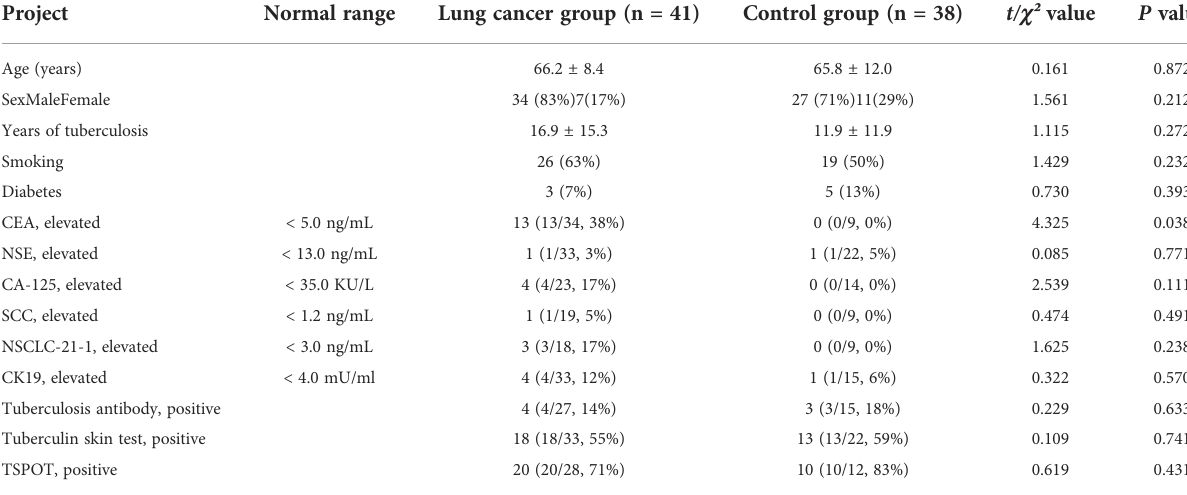
TABLE 1 Clinical data of patients with lung cancer occurrence in a lobe affected by tuberculosis and control group.